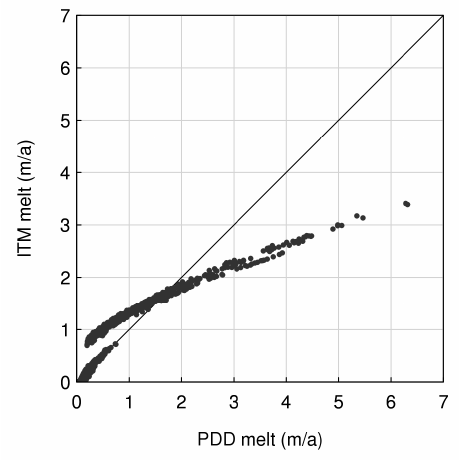
Fig. 6. Annual melt rate calculated using the ITM approach vs. Figure 6. Annual melt rate calculated using the ITM approach vs. annual melt rate calculated annual melt rate calculated using the PDD approach at each point on the ice using the PDD approach at each point on the ice sheet.